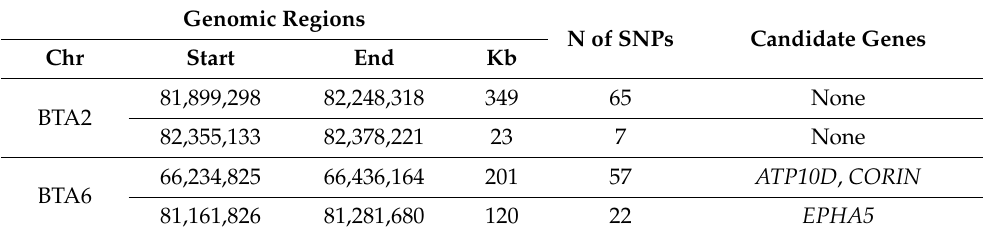
Table 1. Distribution of the significant genomic regions and candidate